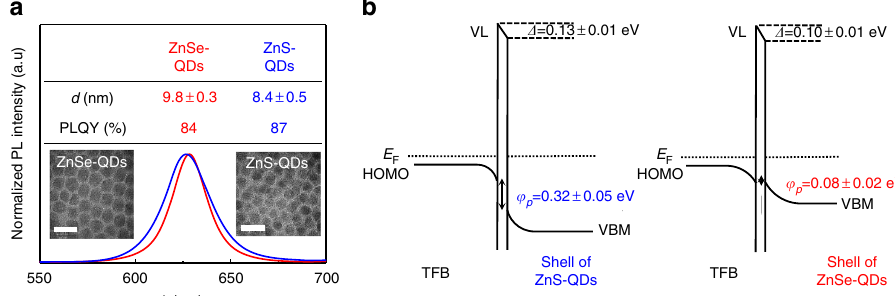
Fig. 1 Colloidal quantum dots. a Photoluminescence spectra of the ZnS-QDs and ZnSe-QDs. Inset: TEM images and a summary of diameter ( d ), and photoluminescence quantum yield (PLQY) of ZnS-QDs and ZnSe-QDs. b Energy band diagrams with Fermi-level alignment at TFB/ZnS-QD and TFB/ ZnSe-QD interfaces. Here, only the energy levels of the shells of QDs are